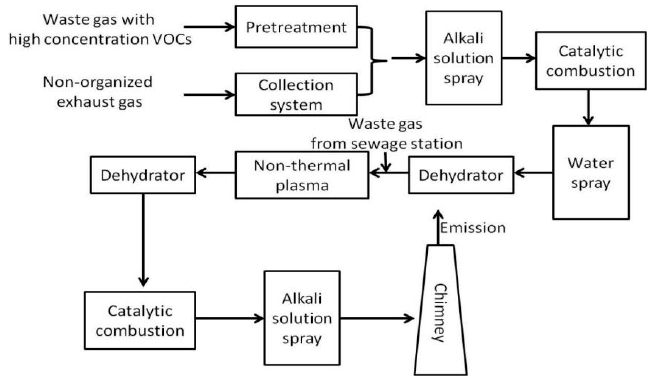
Figure 12. VOCs abatement process in the D factory. Reprinted with permission from [4], 2016, CNKI.